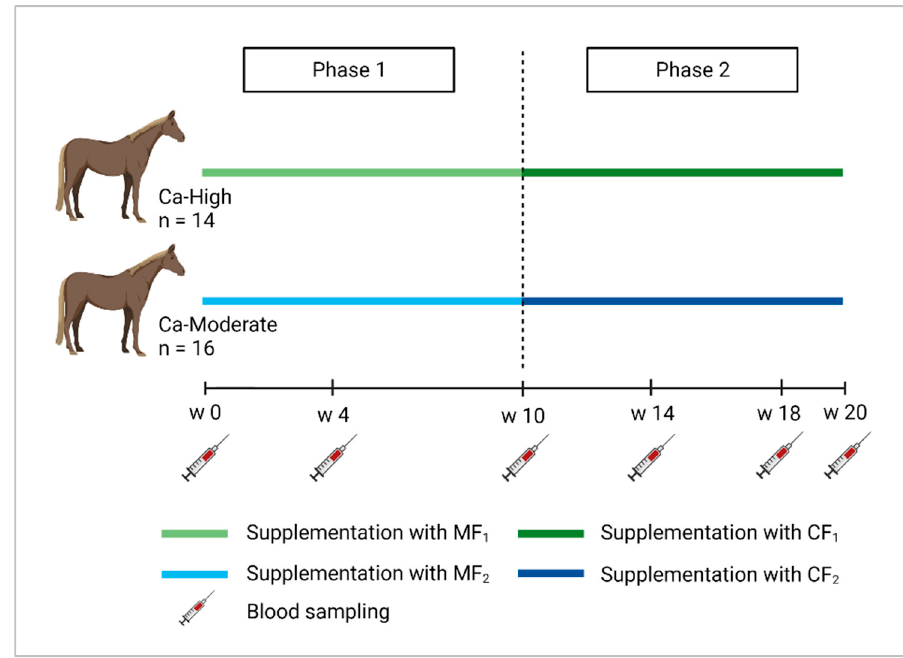
Figure 1. Scheme of the experimental procedure and sampling